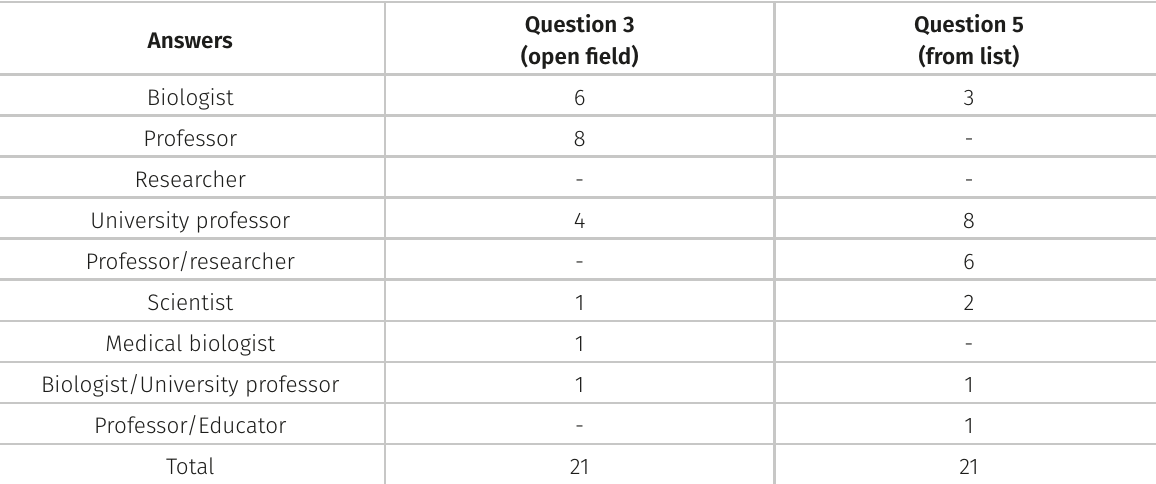
Table I. Frequency of answers for questions 3 and